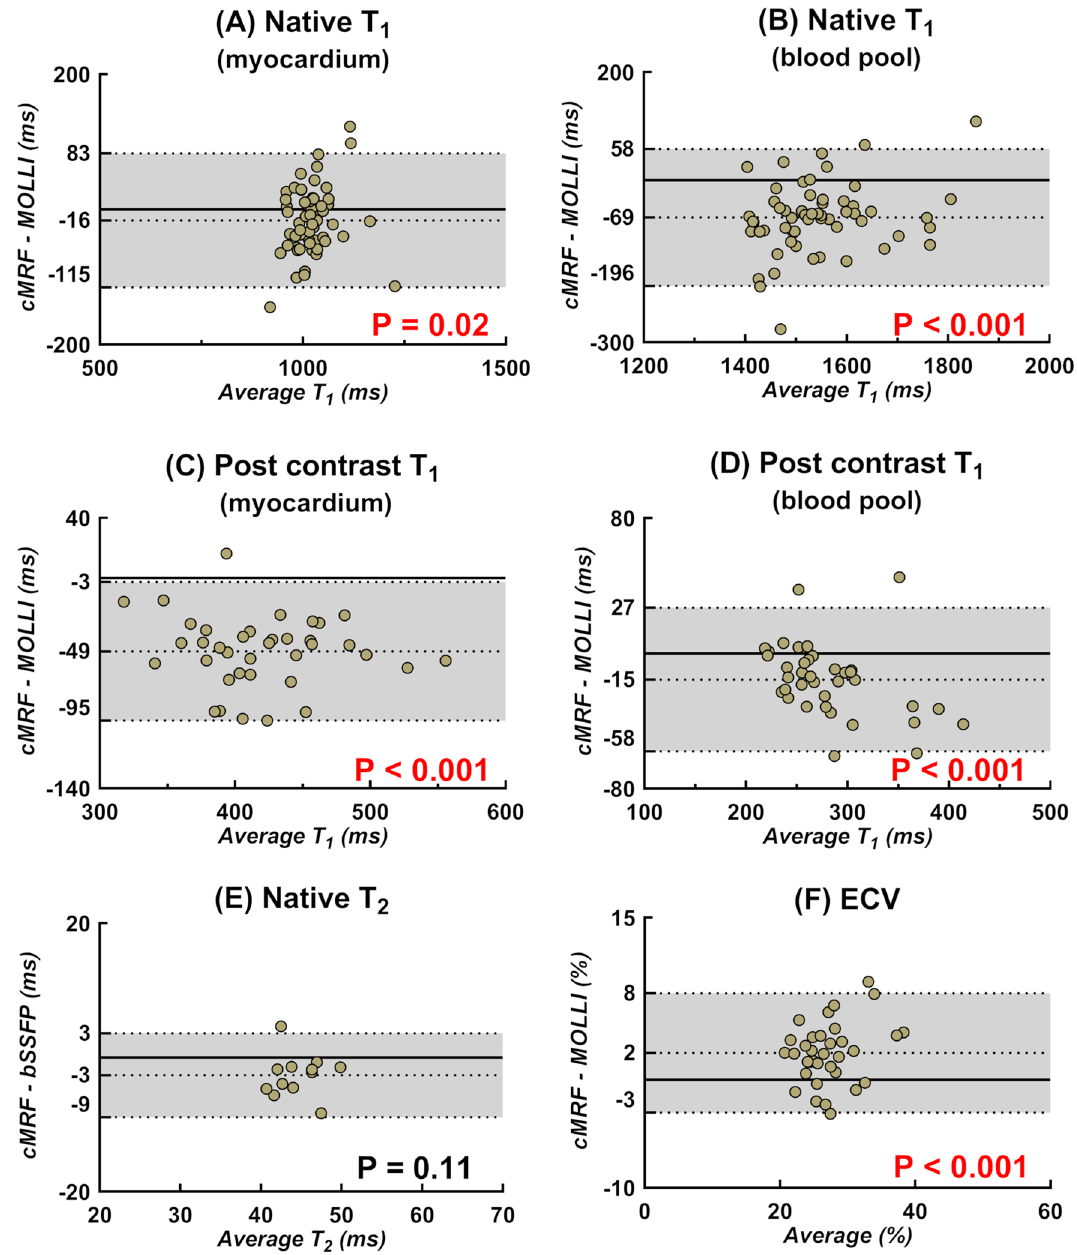
Figure 6. Bland–Altman analyses of short-acquisition-window cMRF and routine techniques for the entire visible left-ventricular myocardium and the left-ventricular blood pool in patients. ( A , B ) Native T 1 relaxation times obtained with cMRF vs. 5(3)3-MOLLI in the myocardium and blood pool areas, respectively. ( C , D ) Post- contrast T 1 relaxation times obtained with cMRF vs. 4(1)3(1)2-MOLLI. A significant bias was observed, while the difference in the post-contrast LV blood T 1 was smaller between the two techniques. ( E ) Native T 2 relaxation times obtained with cMRF vs. T 2 -prepared bSSFP. ( F ) Synthetic ECV calculated with cMRF vs. MOLLI. P-values indicate the significance of the unpaired t-test; P < 0.05 is highlighted in red. None of the measured parameters showed significant trends or changes with increasing